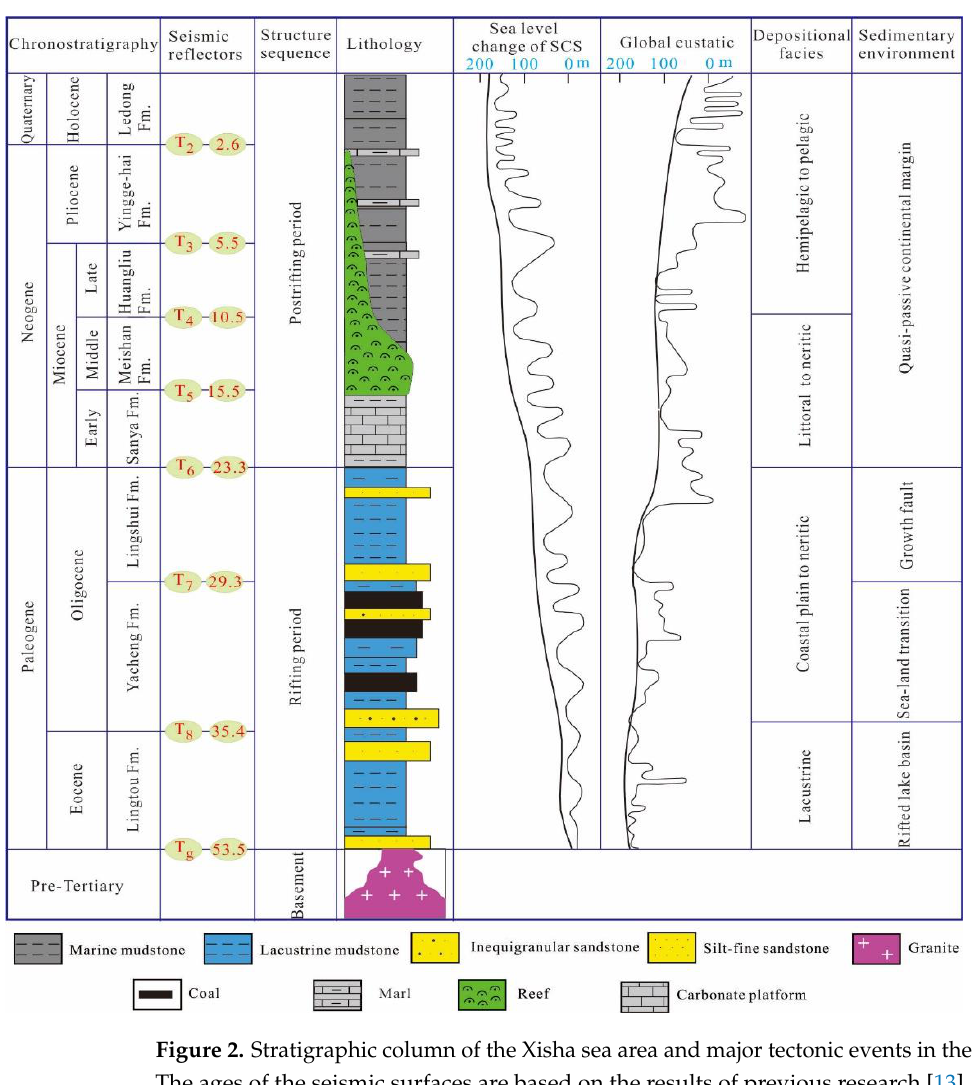
Figure 1. ( A ) Distribution of sedimentary basins and the study area in the northern South China Sea. The sedimentary basins are mapped with black dotted lines. The location of the study area adjacent to the Qiongdongnan and Zhongjiannan Basins is marked by the red rectangle. ( B ) Tectonic divi- sions of the study area and the locations of seismic lines and wells mentioned in the text. The red lines are the locations of seismic profiles showing different carbonate platforms.